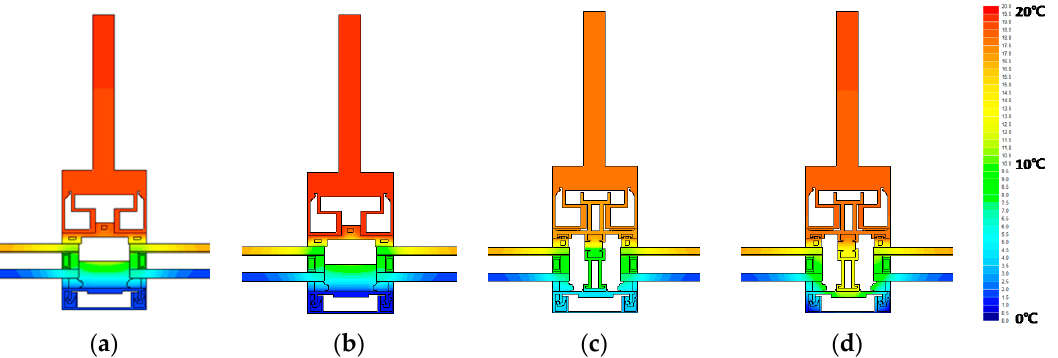
Figure 8. Temperature gradient of frame-profile alternatives. ( a ) T-type, Case B; ( b ) T-type, Case B, Step 1; ( c ) T-type, Case E; and ( d ) T-type, Case E, Step 2.